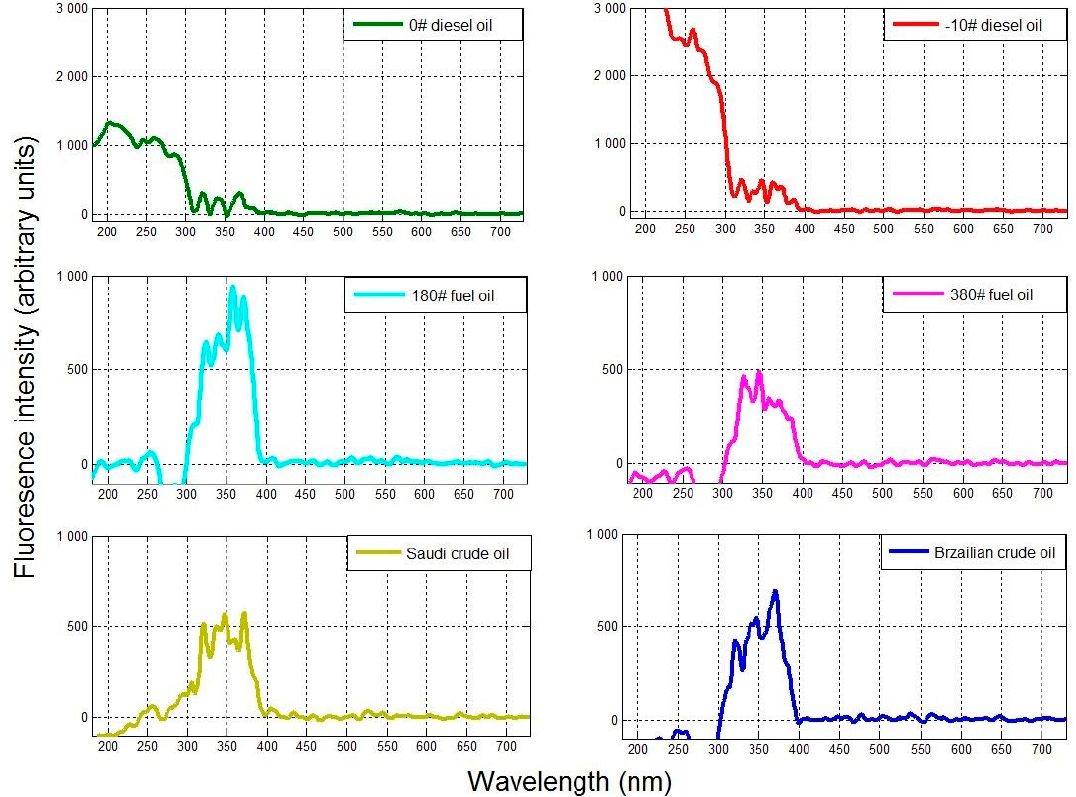
Figure 6. Relative fluorescence intensity (as defined by Equation (2)) for all six oil samples.